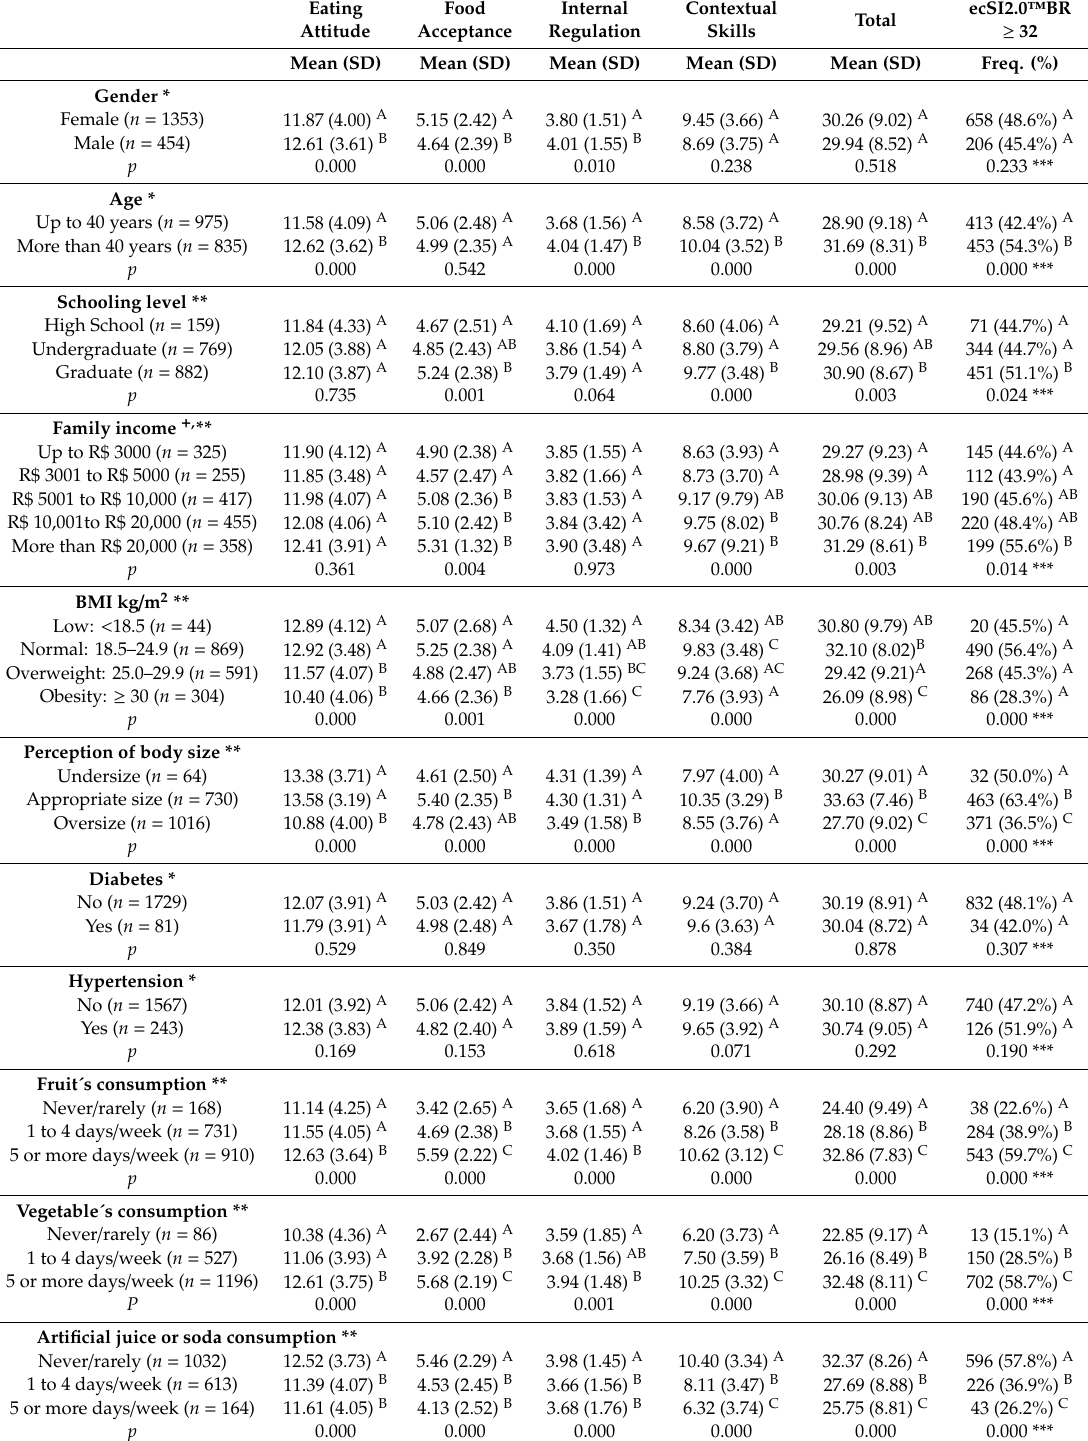
Table 2. Sub-scores of the ecSI2.0 scale subcategorized by sociodemographic variables and health and consumption characteristics ( n = 1810 −